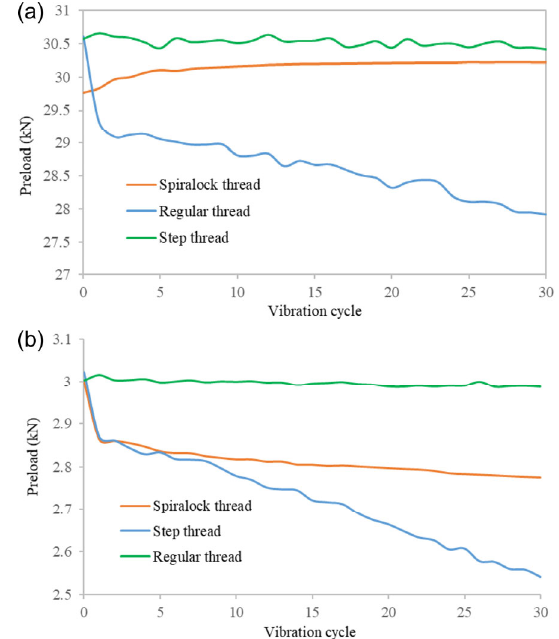
Fig. 27 Changes in preload with the increase in vibration cycles for Spiralock and step threads: (a) large initial preload; (b) small initial